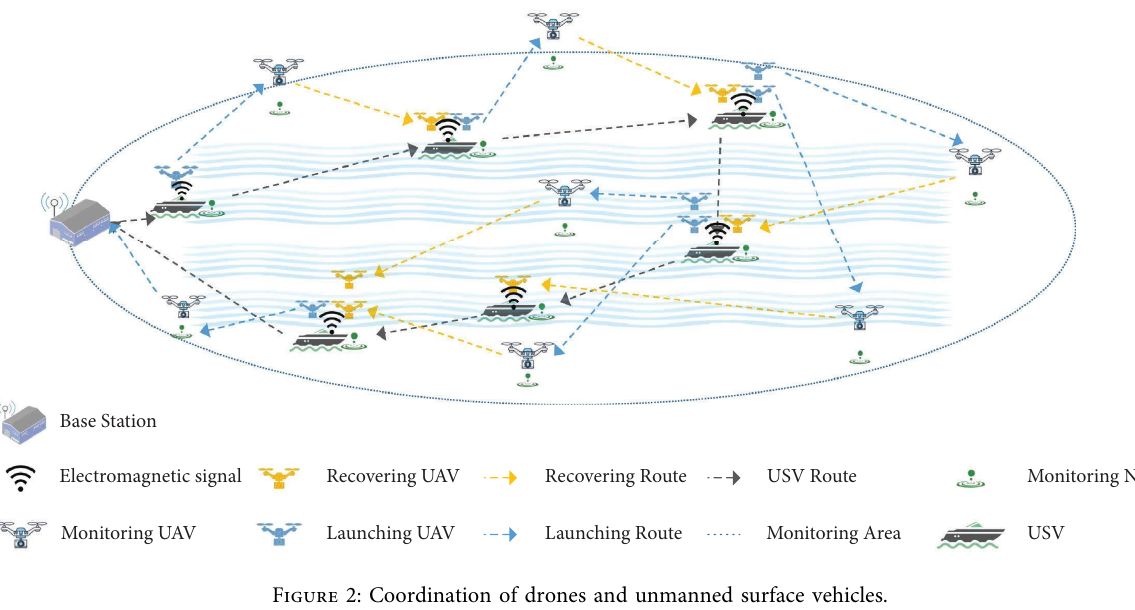
Figure 2: Coordination of drones and unmanned surface